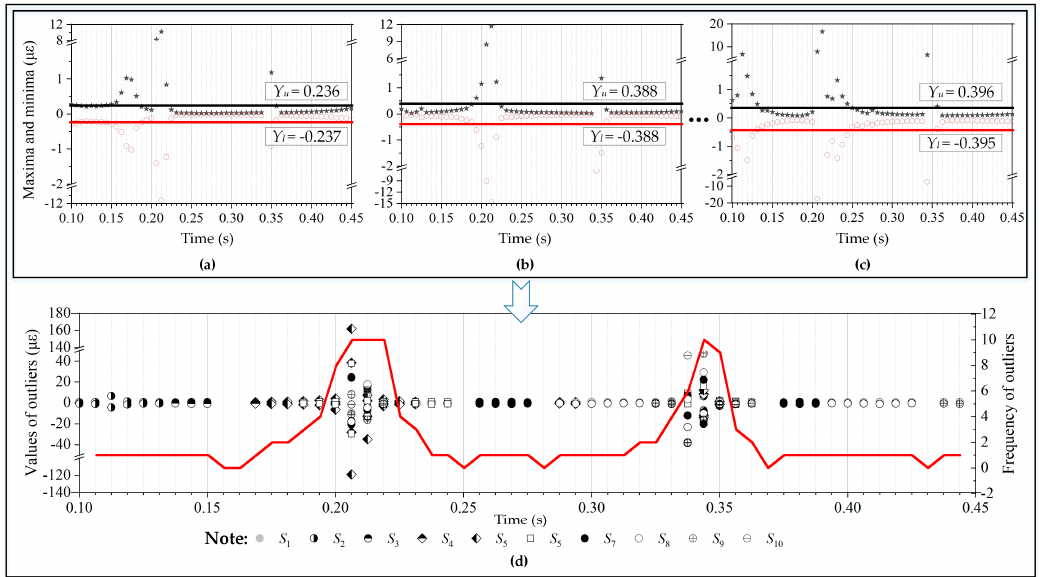
Figure 18. Identified impact processes using sliding window method: ( a ) Thresholds and outliers of S 1 ; ( b ) thresholds and outliers of S 2 ; ( c ) thresholds and outliers of S 10 ; and ( d ) the frequency of outliers during every step of sliding.